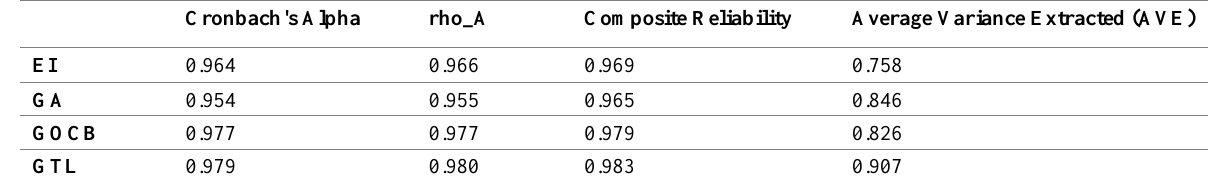
Table 4: Composite Reliability